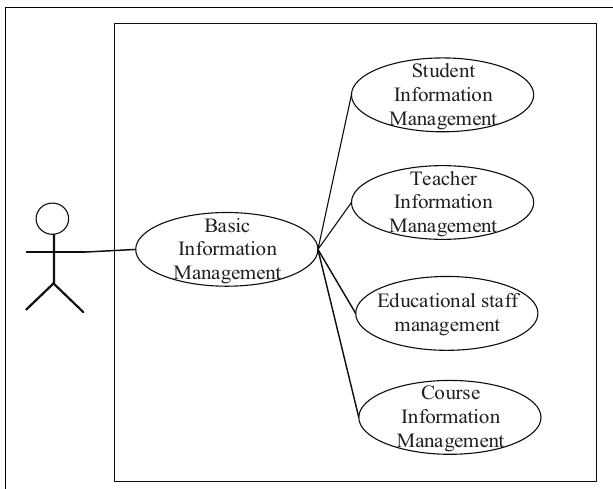
take part in the test. Students log on to the system at a specified time to participate in the test. After completing the test, they submit the answer information.